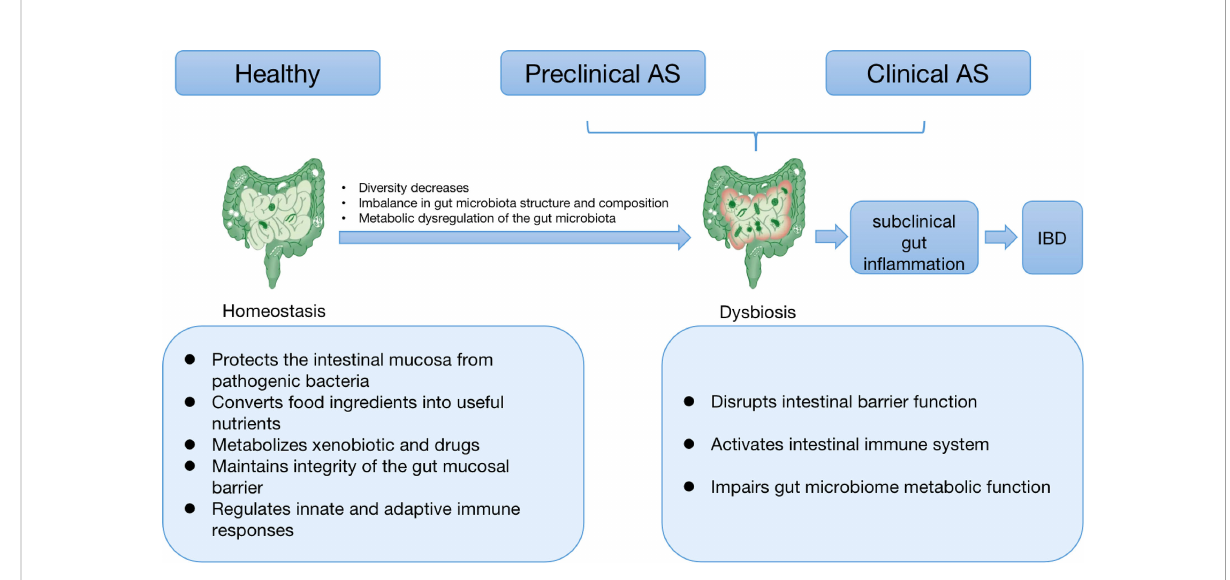
FIGURE 1 The relationship between intestinal dysbiosis, intestinal in fl ammation, and AS. Healthy gut microbiota is mainly responsible for human health. Gut microbial homeostasis imparts a speci fi c function in protecting the intestinal mucosa from pathogenic bacteria, converting food components into valuable nutrients, metabolizing xenobiotics and drugs, and maintaining the integrity of the gut mucosal barrier and intestinal immune homeostasis. When species diversity begins to decline, the composition and function of intestinal microbiota change, and metabolism becomes dysregulated, we see a breakdown of the symbiosis, known as dysbiosis. Dysbiosis can disrupt intestinal barrier function, activate the intestinal immune system, and impair the metabolic process of the intestinal fl ora, thereby leading to subclinical intestinal in fl ammation. As the in fl ammation further intensi fi es, it develops into IBD with clinical manifestations. As is often accompanied by subclinical intestinal in fl ammation or IBD, some patients have suffered from dysbiosis in preclinical disease. This suggests that AS and IBD may have a common etiology – disturbed gut microbiota. In addition, there is a strong correlation between the severity of gut in fl ammation and the degree of spine in fl ammation in AS. Taken together, intestinal in fl ammation and immune responses in AS may be possible consequences of microbial dysbiosis. AS: ankylosing spondylitis; IBD: in fl ammatory bowel